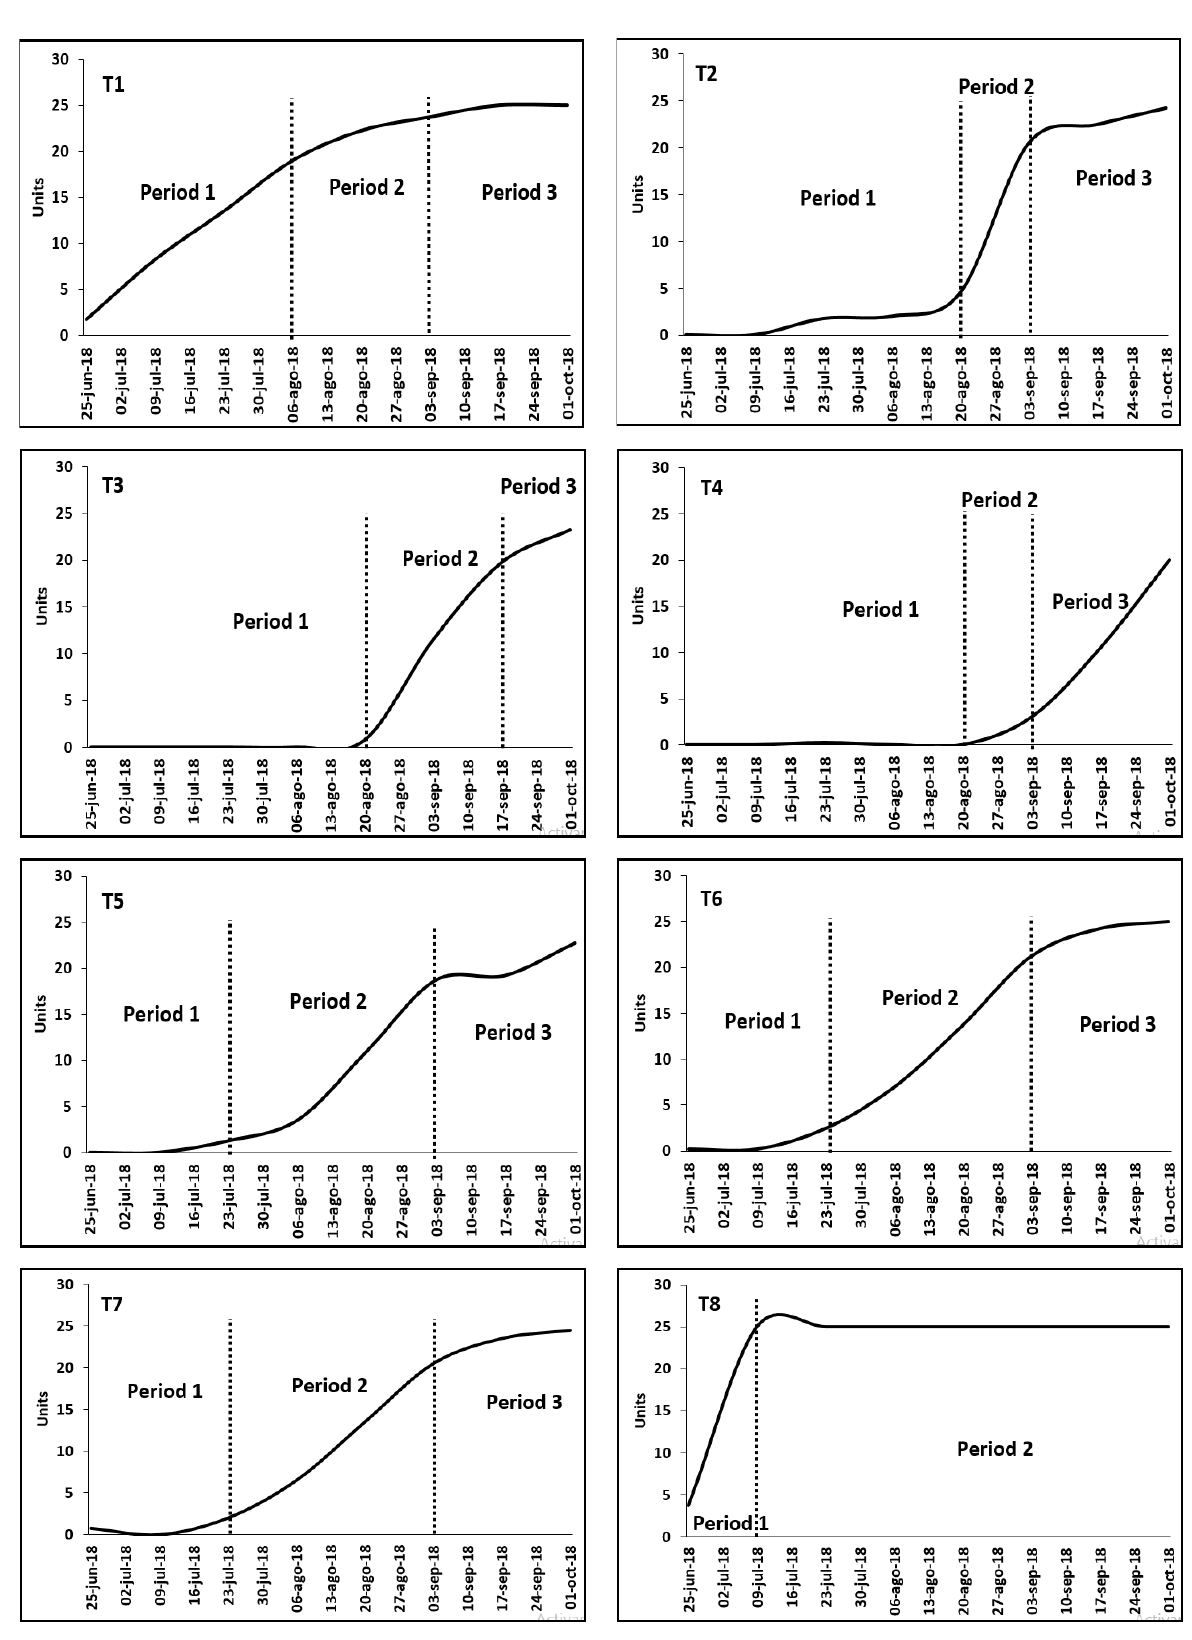
Figure 3. Curves of inflorescence number vs. time in the experiment with pineapple cv.‘MD2’ in Satipo. FIT, flower induction treatment; T1, AVG 0 mg/L and without FIT; T2, AVG 150 mg/L and without FIT (11 applications); T3, AVG 250 mg/L and without FIT (11 applications); T4, AVG 350 mg/L and without FIT (11 applications); T5, AVG 150 mg/L and without FIT (6 applications); T6, AVG 250 mg/L and without FIT (6 applications); T7, AVG 350 mg/L and without FIT (6 applications); T8, AVG 0 mg/L and with